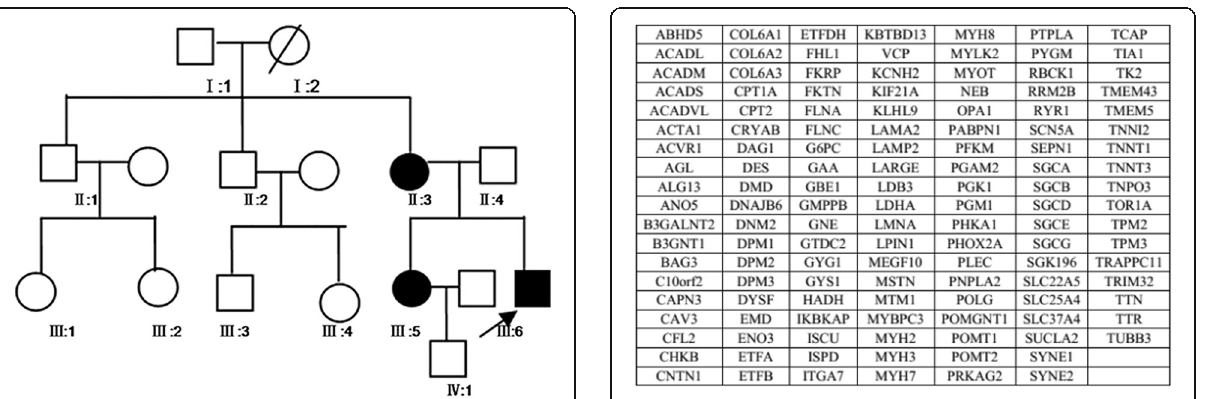
Fig. 1 Pedigree of the familial Emery – Dreifuss muscular dystrophy with SYNE1 Gly2304Arg mutation. The arrow indicates the proband; circle , female; square , male; Slashed symbol, deceased family member; black symbol , affected family member; Blood samples were available from the proband (III:6) and family members (II:3, II:4, III:3, III:4 and III:5)